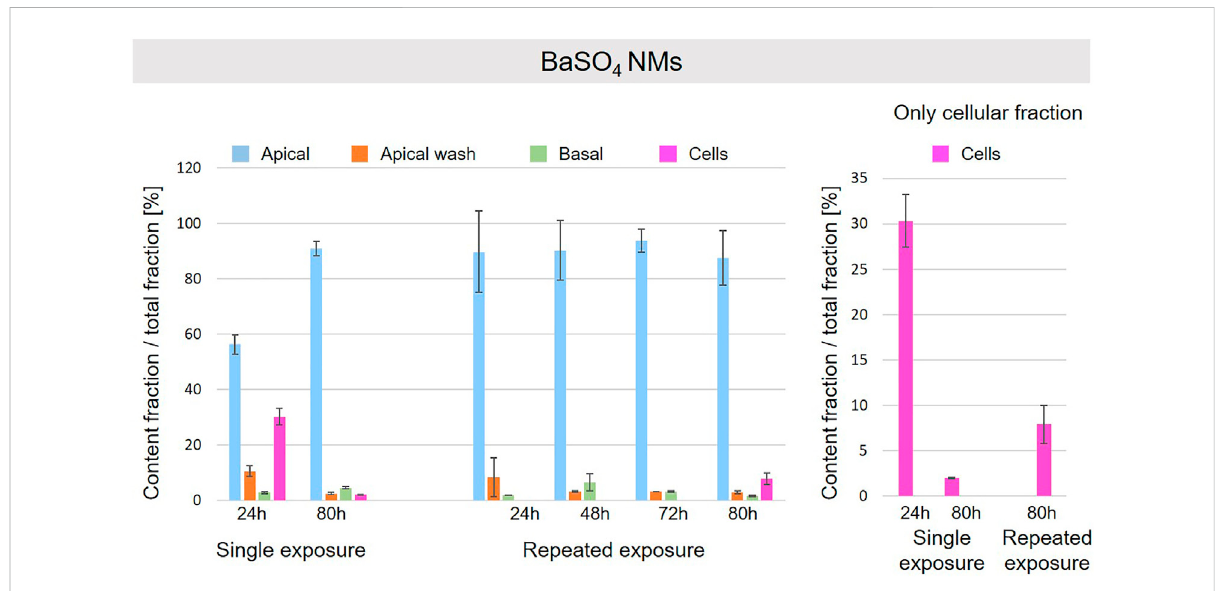
FIGURE 5 Fate of BaSO 4 NMs at the A549 tissue barrier after single and repeated exposures. For single exposures BaSO 4 NMs was exposed at a concentration of 100 µg/ml and the different fractions were collected after incubation for 24 and 80 h. For repeated exposures the cells were exposed repeatedly every day up to 80 h, using 25 µg/ml BaSO 4 NMs concentration, resulting in a total exposure of 100 µg/ml and 80 h incubation time intotal. Apical, apical cellwashandbasal sampleswerecollectedafter 24, 48, 72,and 80 hofexposure.Right side: This graph onlydepicts the cellular fraction. A total of three independent experiments ( n = 3), with three single replicates each, were performed.